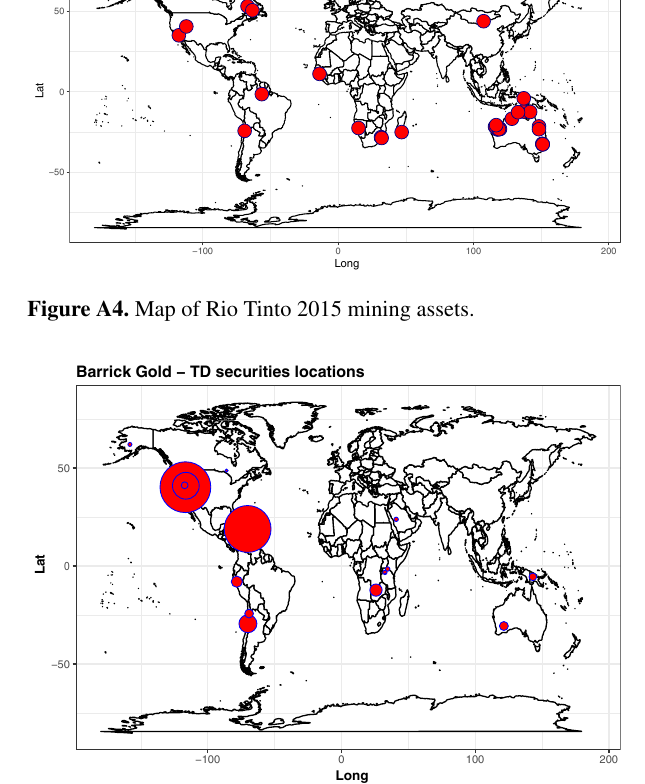
Figure A5. Map of Barrick Gold assets reported in TD Securi- ties (2016a).